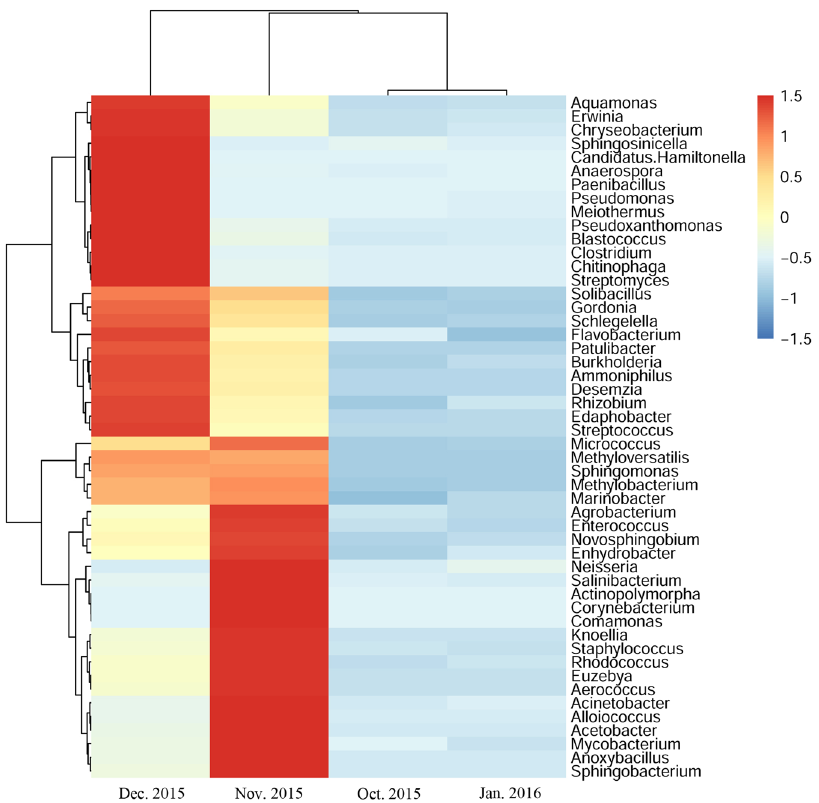
Figure 10. Heat maps of Dendroctonus armandi larval gut bacterial family in each month from October 2015 to January